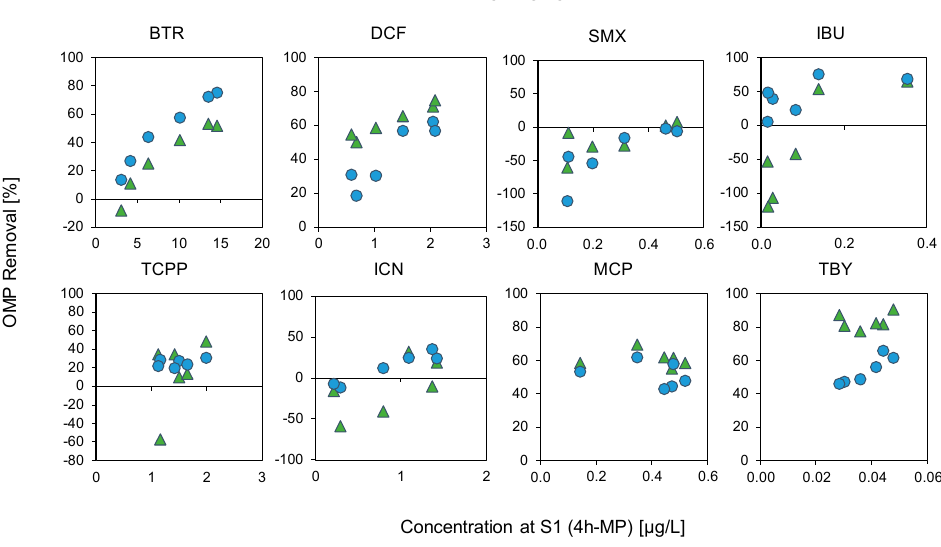
Figure 8. OMP removal of selected OMPs in dependence of the inflow concentration (S1) for the treatment stages with PAC and GAC for WW2, Q PAC = 1402–1988 L/s, Q GAC = 141–181 L/s.